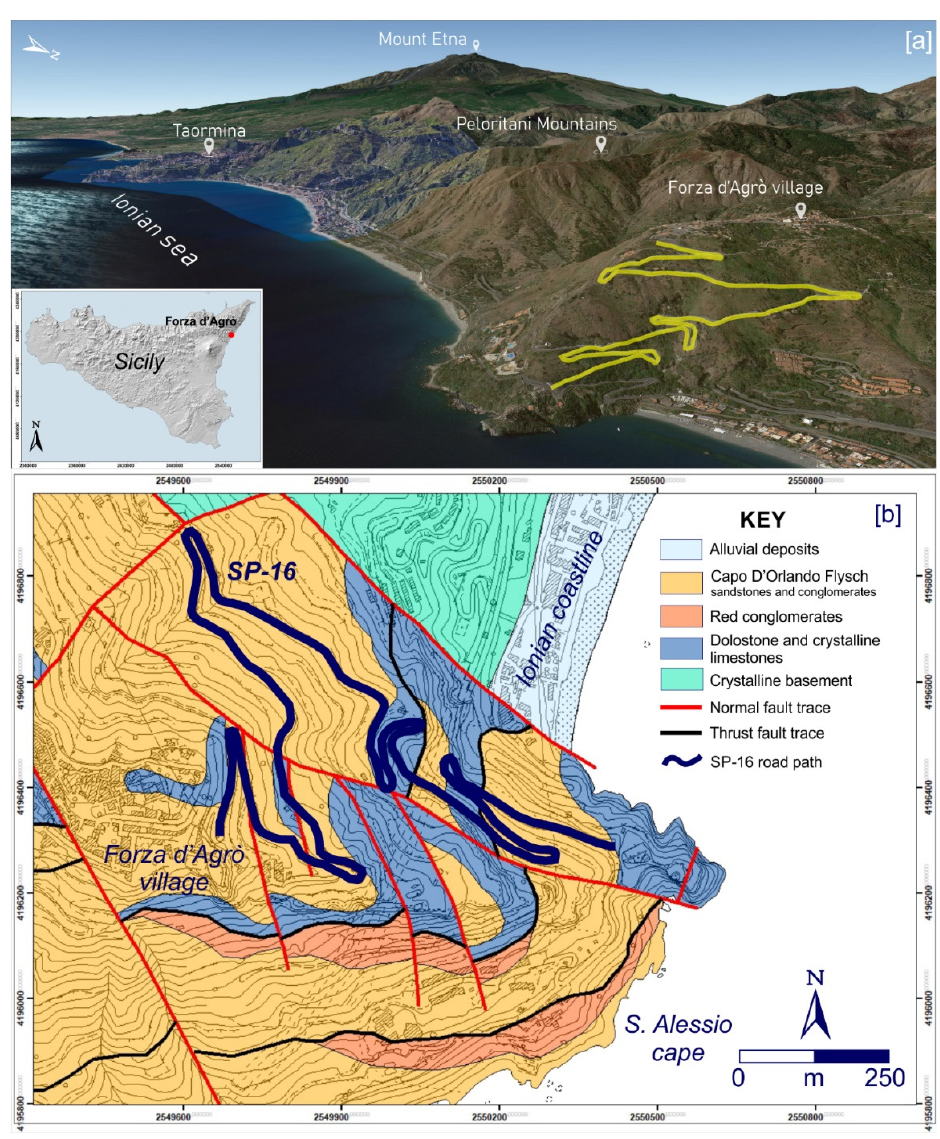
Figure 1. ( a ) Geographical location of the study area and panoramic view (Google Earth) with the studied road path highlighted; ( b ) geological map of the study